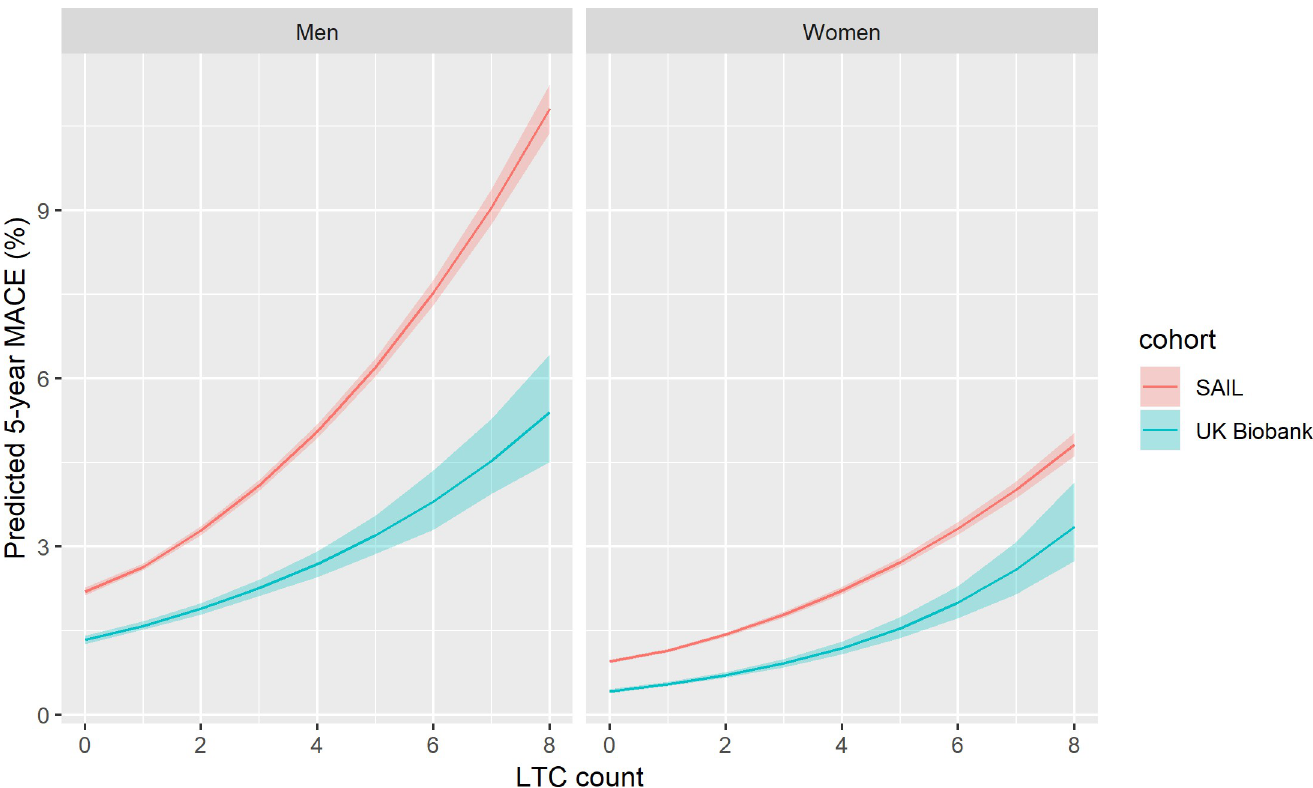
Fig 7. Relationship between LTC count and absolute risk of MACE for UK Biobank and SAIL. Lines indicate the modelled 5-year risk of MACE. Shaded area indicates 95% confidence interval. Predicted values are modelled at mean age for UK Biobank (56.5 years) and UK national mean Townsend score for socioeconomic status. LTC, long-term condition; MACE, major adverse cardiovascular event; SAIL, Secure Anonymised Information Linkage.